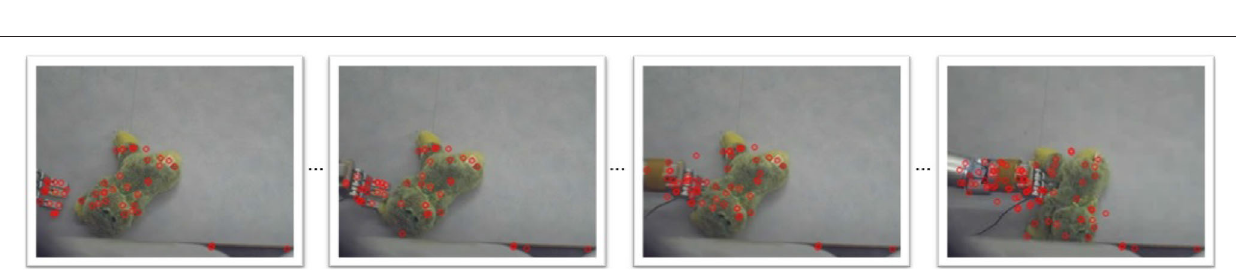
FIGURE 6 | Vibrotactile features produced when the robot performed the shake behavior on an object from the medicine bottles category.